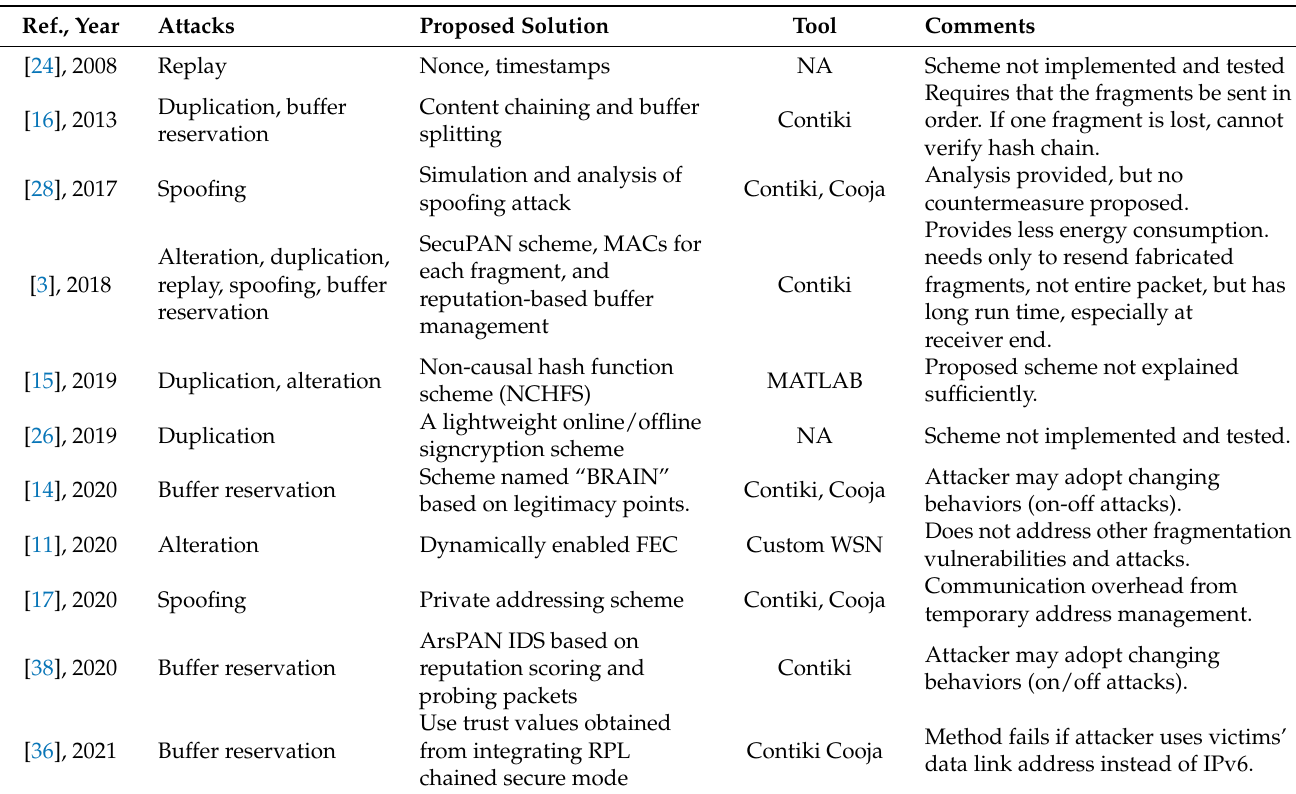
Table 1. Literature review